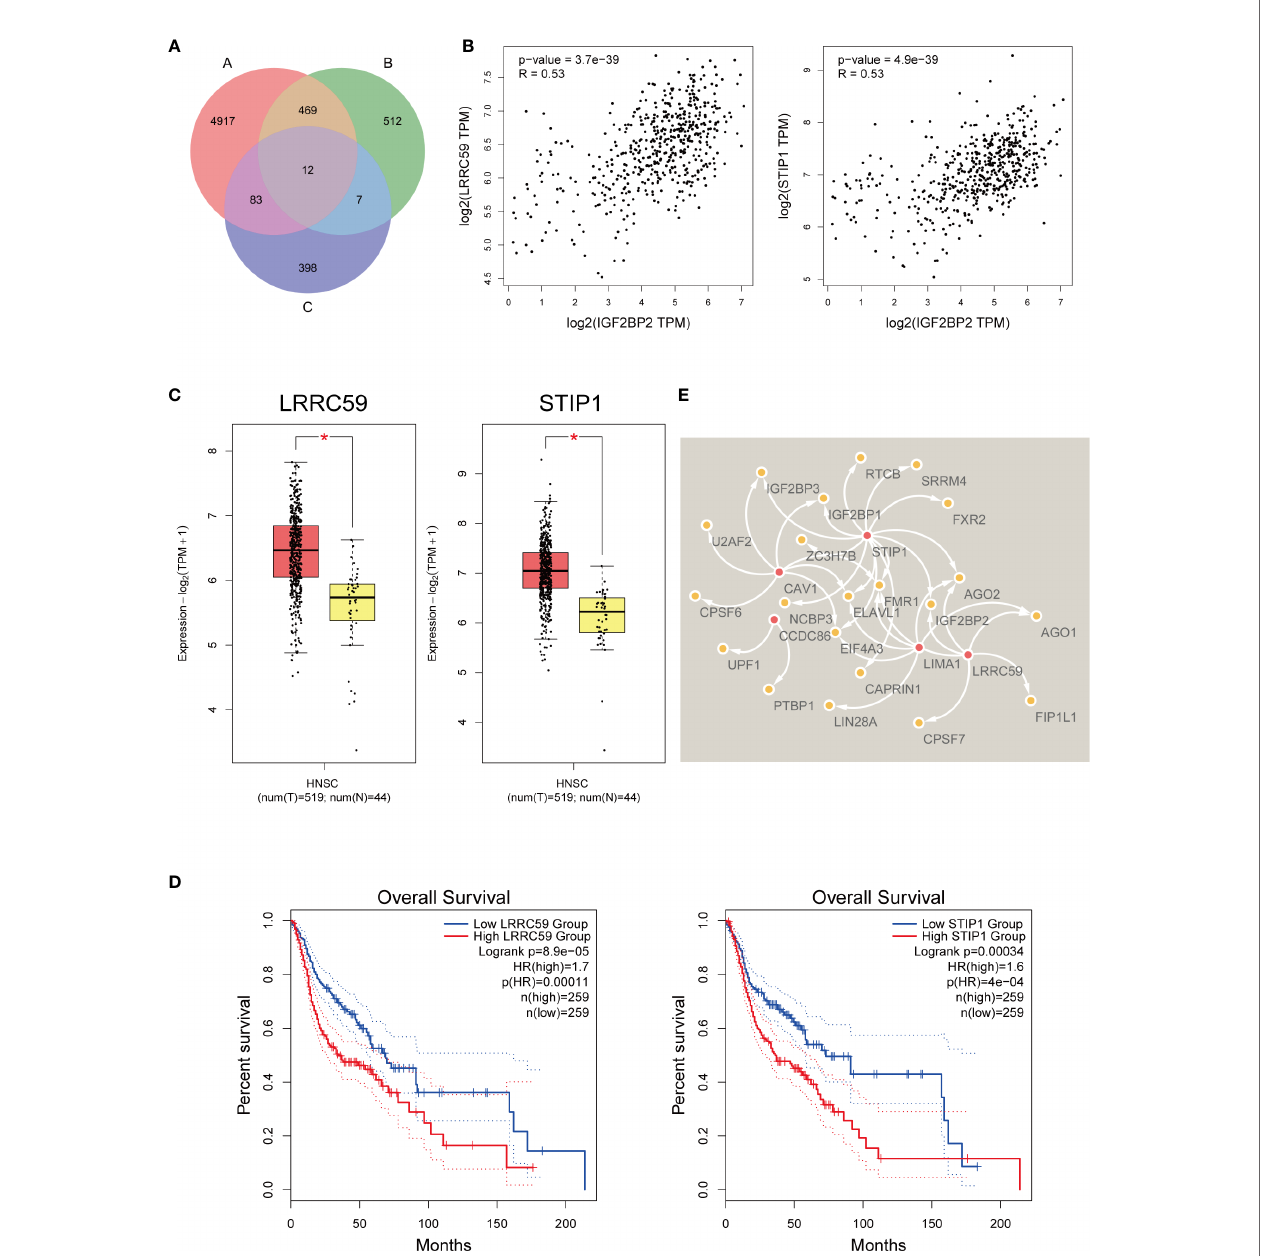
FIGURE 5 | IGF2BP2-associatedgenesthatmediatem 6 Amodi fi cation. (A) VennchartofIGF2BP2-relatedgenesinHNSCC. (B) ThecorrelationofLRRC59,STIP1, and IGF2BP2. (C) TheexpressionofLRRC59andSTIP1was con fi rmedwithGEPIA2.T,tumortissue.N, normaltissue.* meansp-value<0.01. (D) Kaplan-Meiersurvivalcurves illustratethe differenceinOSaccordingto theexpressionofLRRC59andSTIP1. (E) The